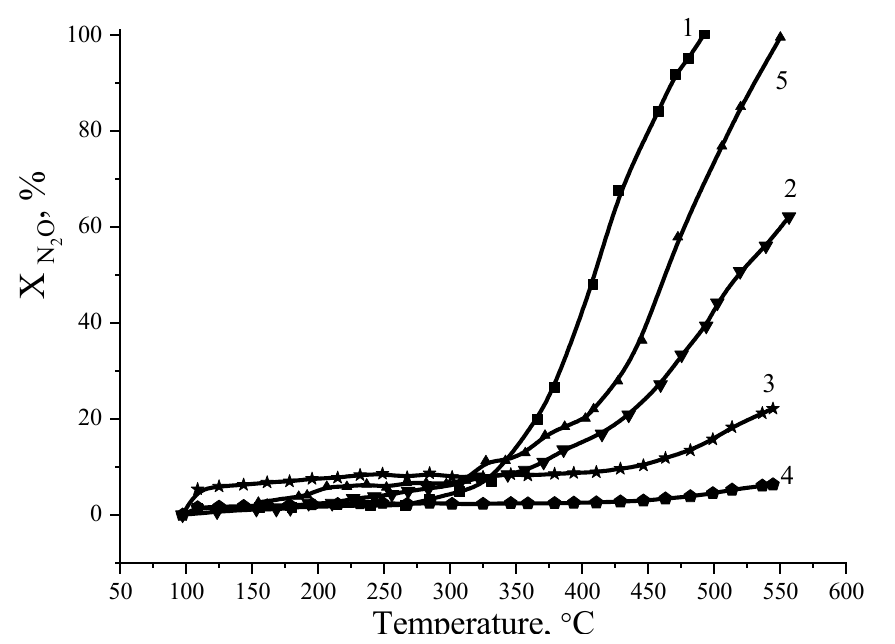
Figure 8. The effect of temperature on the degree of N 2 O decomposition. Calcination temperatures, °C: 1—350; 2—400; 3—450; 4—1100; 5—AVC-10.